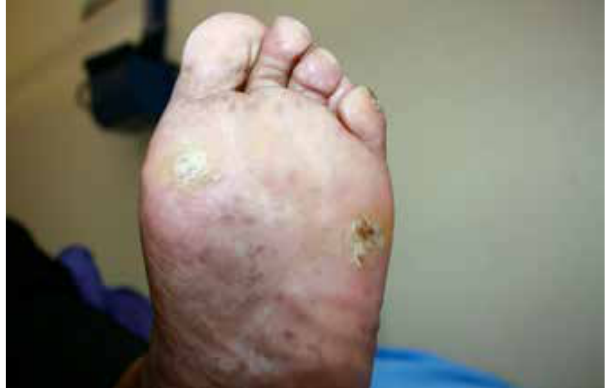
Figure 7: Plantar warts